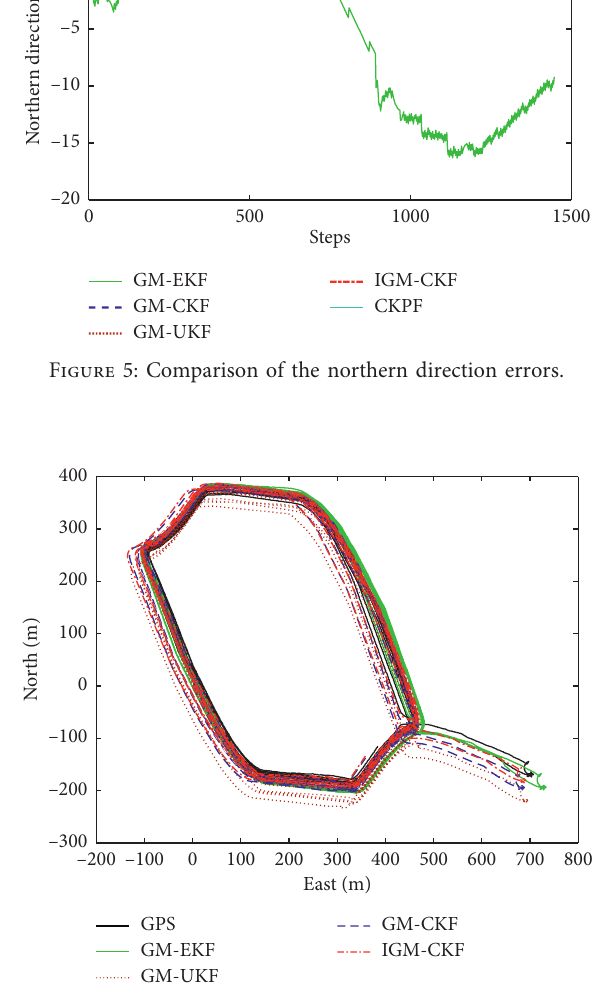
Figure 6: Comparison of the trajectory estimations based on 39,000 data points. In Figure 6, the starting point is ( 0 , 0 ) , and the end point is ( 383 . 5 , − 115 . 4 ) .